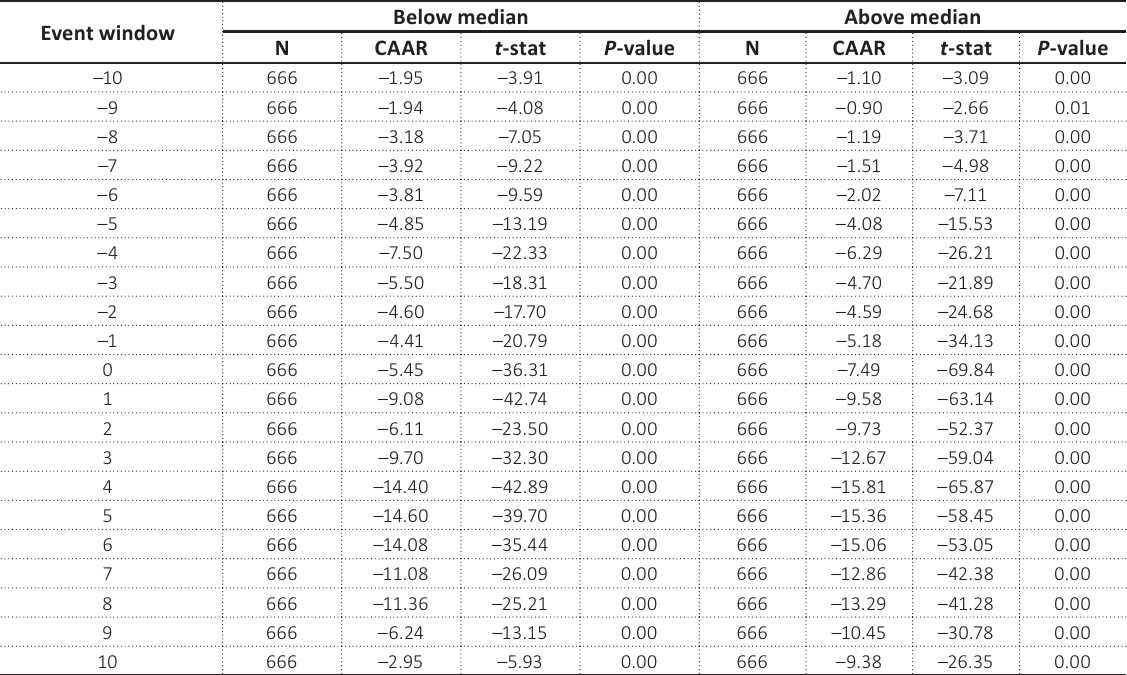
Table 7. Day wise CAAR for both above-median and below-median market capitalization firms on the COVID-19 outbreak in different event